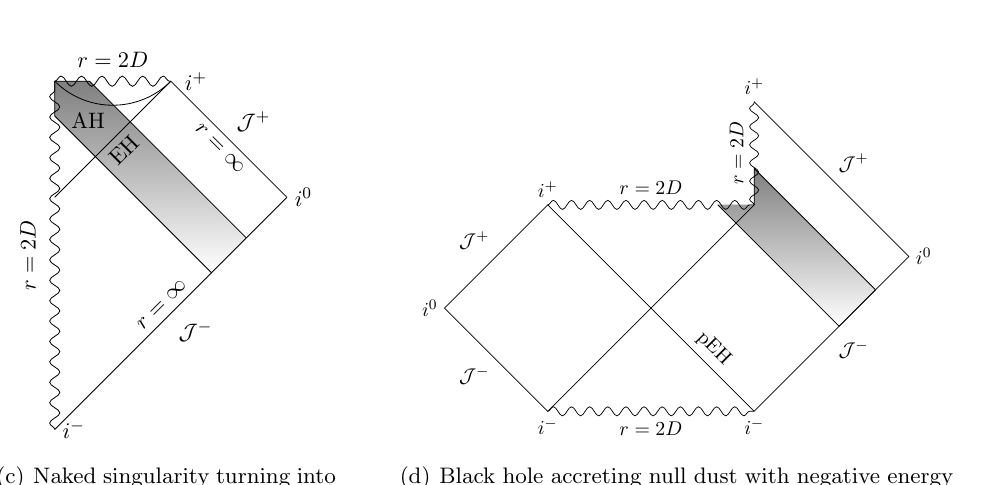
(a) White hole radiating and turning into naked singularity.